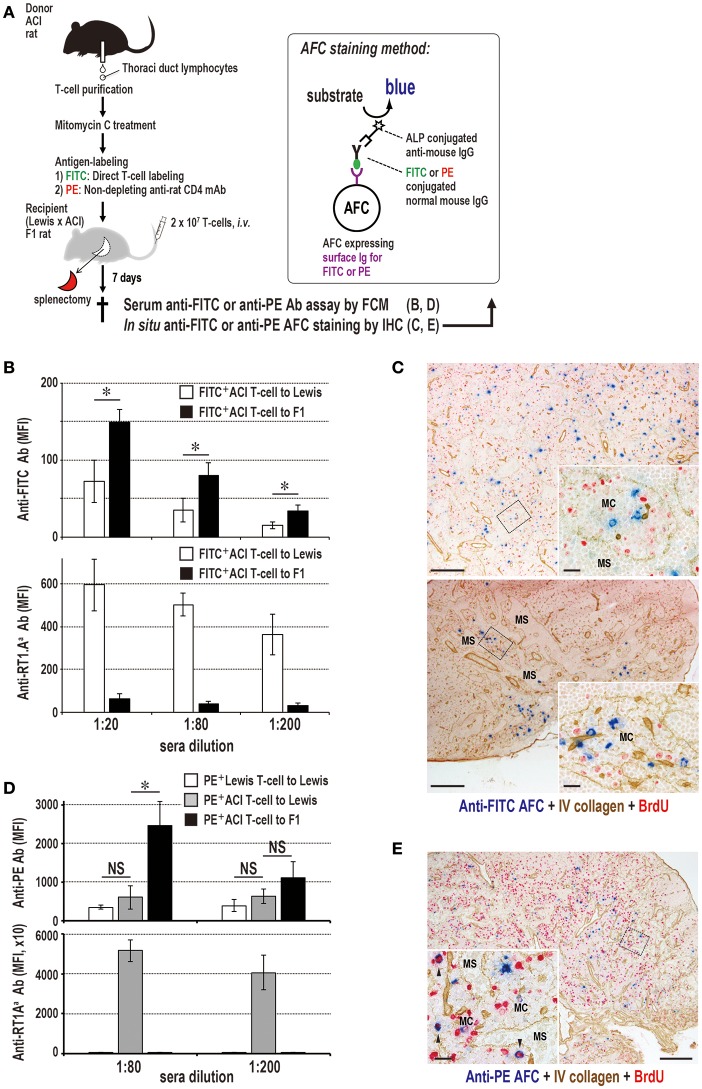
Antibody production to labeled antigens without DST antibodies in F1 rats that received parental T cells. (A) Experimental protocol for detecting specific antibody production in sera and the LNs. T cells were labeled either with FITC directly or with PE-conjugated ant-rat CD4 mAb. AFC, antibody-forming cells. (B,D) Antibody responses in parental ACI (RT1.AaBa) to (Lewis × ACI)F1 hybrid rat (RT1.AalBal) combination concerning anti-donor MHCI, anti-FITC (B), and anti-PE (D) antibodies in recipient sera. Both anti-FITC and anti-PE antibodies of parental to F1 rat combination had considerably higher titers than those of the allogeneic control. In contrast, DST (anti-RT1.Aa) antibodies were negligible, whereas, allogeneic control induced an intense level of DST antibodies (mean ± SD, n = 3 rats each, *P < 0.05). MFI, mean fluorescent intensity. (C,E) Double immunostaining for anti-FITC (blue, C) or anti-PE (blue, D) and type IV collagen (brown) in F1 rat LNs 7 days after antigen-labeled parental T cell injection. Specific antibody-forming cells (AFCs, blue) against labeled antigen were detected polytopically in the medullary cord of F1 rat LNs 7 days after injection. C, cervical (upper panel) and mesenteric (lower panel) LNs; E, mediastinal LNs; MC, medullary cord; MS, medullary sinus. Scale bar = 100 μm (C,E) or 20 μm (C,E insets).